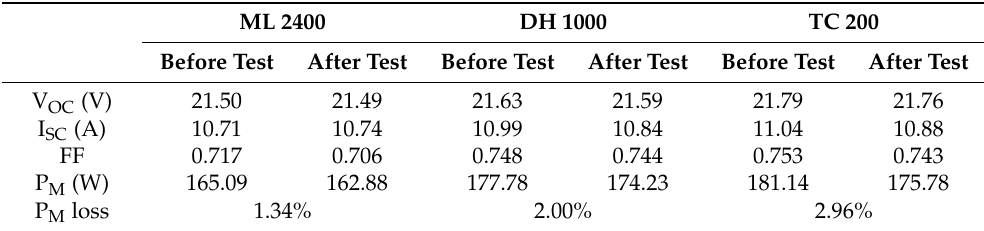
Table 1. Result of standard reliability tests of lightweight shingled-type PV modules under IEC 61215 viz. mechanical load 2400, damp heat 1000 and temperature cycling 200